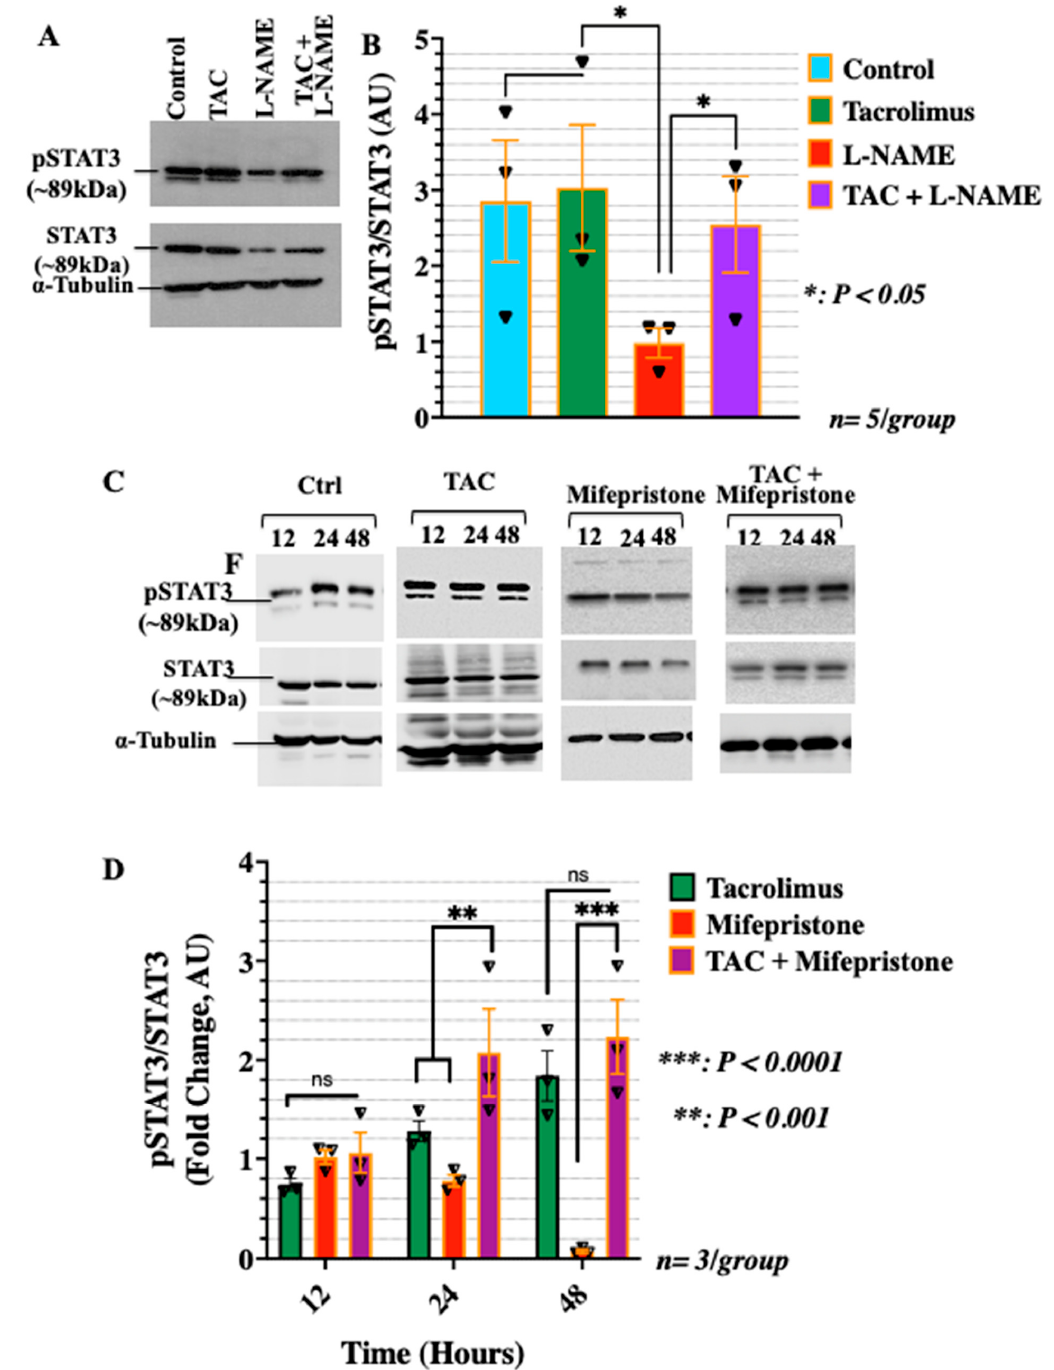
Figure 3. Tacrolimus abrogates the suppressive effects of L-NAME and mifepristone without altering the expression and activation of STAT3 in HTR-8/SVneo cells. ( A , B ): Representative Western blot ( A ) and densitometric analysis ( B ) of pSTAT3-Y705 and STAT3 in the HTR-8/SVneo cells treated, respectively, with tacrolimus, L-NAME, and a combination of both after 24 h and the untreated control. It is evident that tacrolimus has the potential to counteract the suppressive effect of L-NAME on the expression and activation of the PGR and STAT3 in HTR-8/SVneo cells cultured under nitrosative stresses in vitro. Similarly, tacrolimus was able to override the inhibitory actions of mifepristone on STAT3 expression and phosphorylation at STAT3-Y705 in HTR-8/SVneo cells ( C , D ). Band intensity was generated using the ImageJ software. Data represent the mean intensity with error bars representing the S.D. TAC: